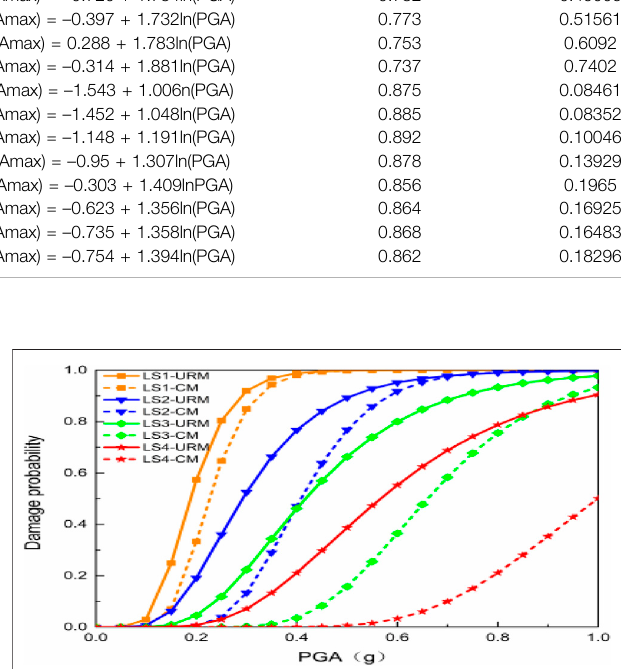
FIGURE 11 | Effect of con fi ning members on fragility curves of the mainshock-damaged CM and URM model subjected to aftershocks ( δ (cid:2) 1). Effect of Aftershocks on Seismic Fragility of Masonry Structures Under